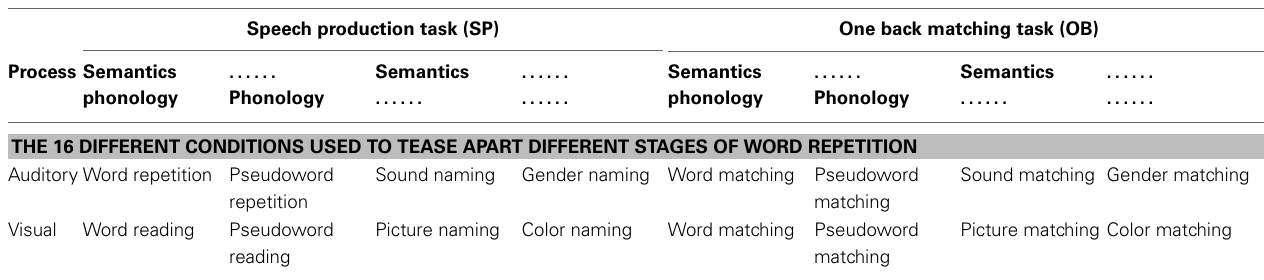
Table 3 | A schematic representation of the 16 tasks employed in this work, associating each task with the key factors: stimulus modality (auditory vs. visual); process (semantic and/or phonological content); and response modality (SP vs.